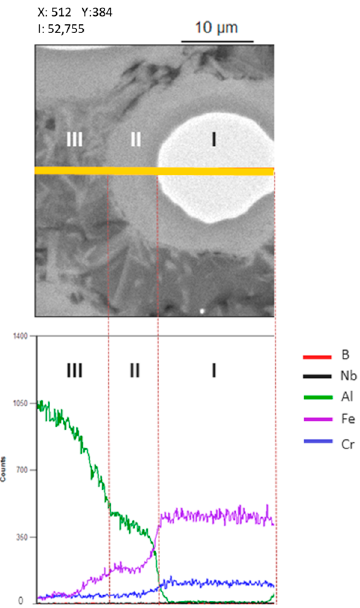
Figure 4. Line EDS of a partially reacted alloy particle in the residual Al matrix in the composite obtained by SPS of Al–50 vol.% Fe 66 Cr 10 Nb 5 B 19 . SPS conditions: temperature—570 °C, holding time—3 min, applied pressure—40 MPa.